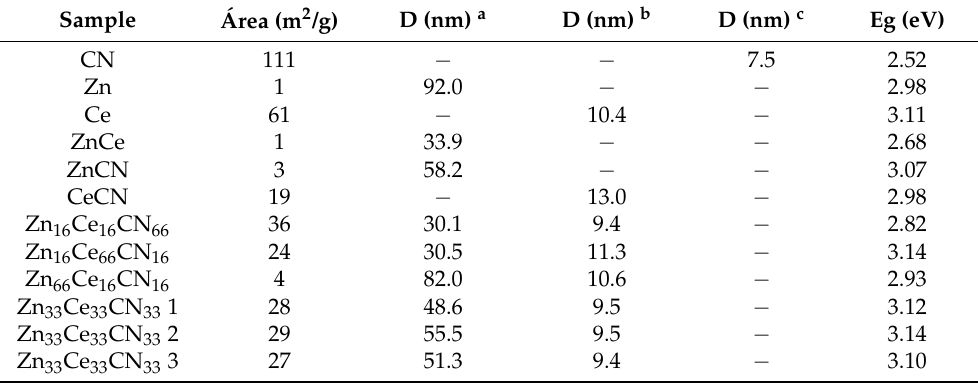
Table 2. Surface area, crystal size, and Eg.